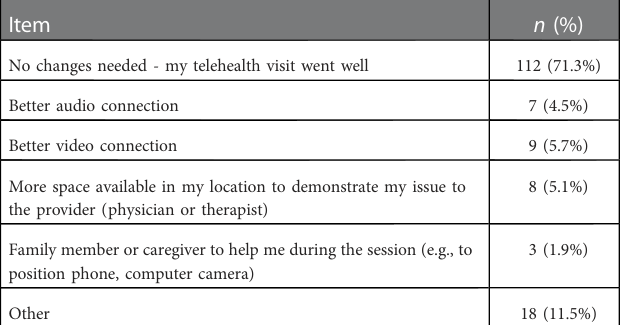
TABLE 3 Patient-reported ways to make their telehealth visit better or more